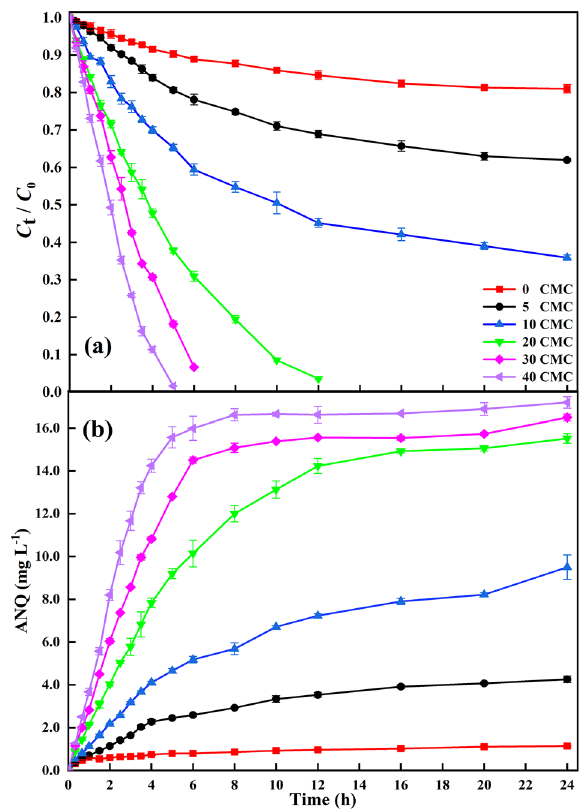
Figure 1. The degradation of ANT and the production of ANQ within 24 h changed with time. Transformation of 20 mg L -1 ANT and accumulation of ANQ by 1.88 U mL -1 laccase with 2 mM HOBt in the presence of different concentrations of Tween 80 in 0.2 M sodium acetate solutions, pH 4.5 at 30 °C after 24 h incubation period: ( a ) Transformation rates of ANT by LMS-HOBt in the presence of Tween 80; ( b ) Accumulation of ANQ according to ( a ). Error bar represents standard deviations (n =